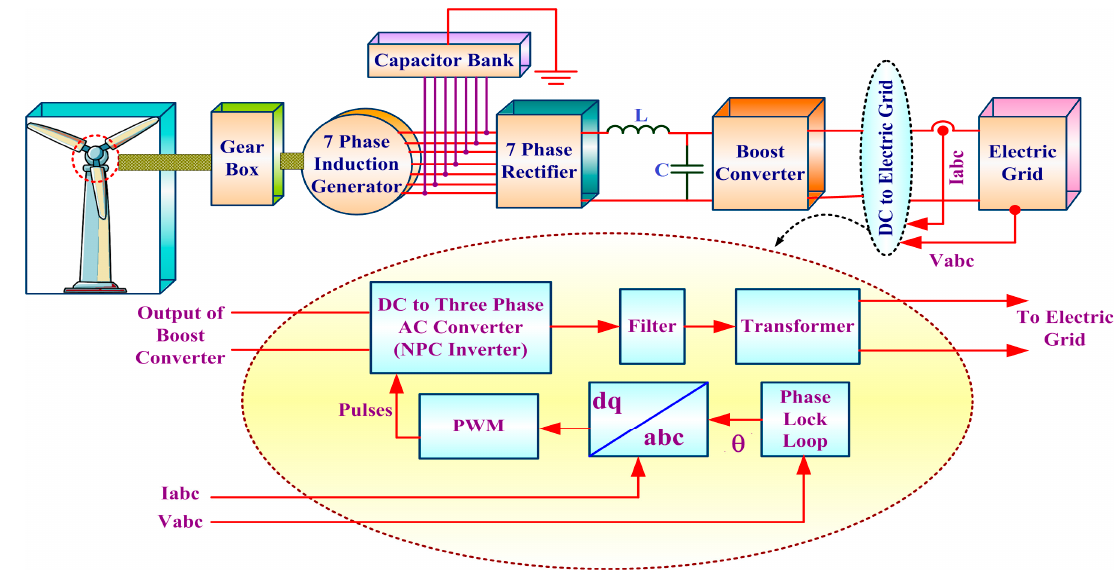
Figure 1. Seven Phase Grid Connected Wind Electric Generator.